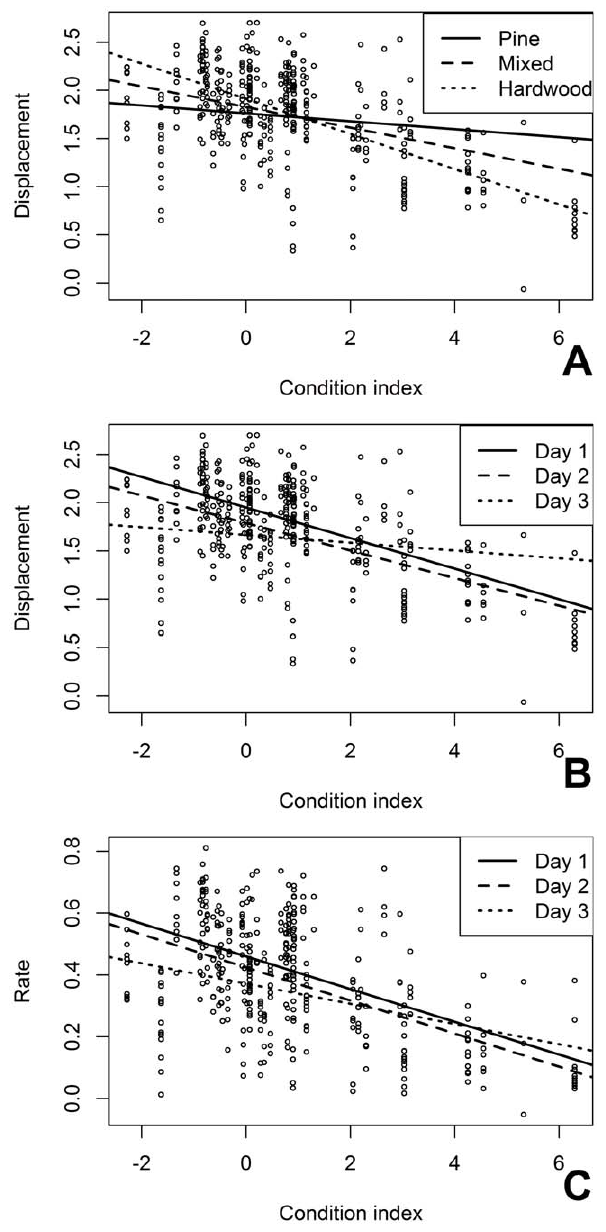
Figure 5. The influence of energetic condition on migrant movement varies with habitat type and day of stopover. Fitted values were extracted from mixed models with seven fixed effects and the individual bird as a random component on the log transformed linear displacement distance (m) and movement rate (m min 2 1 ) during two hour increments throughout the first three days of stopover. Model fitted linear displacement distance of migratory red-eyed vireos in relation to energetic condition (condition index is relative to lean body mass [0, see text]) in three forested habitat types and on the first through third day of stopover (A and B). Model fitted movement rate in relation to energetic condition on the first, second and third day of stopover